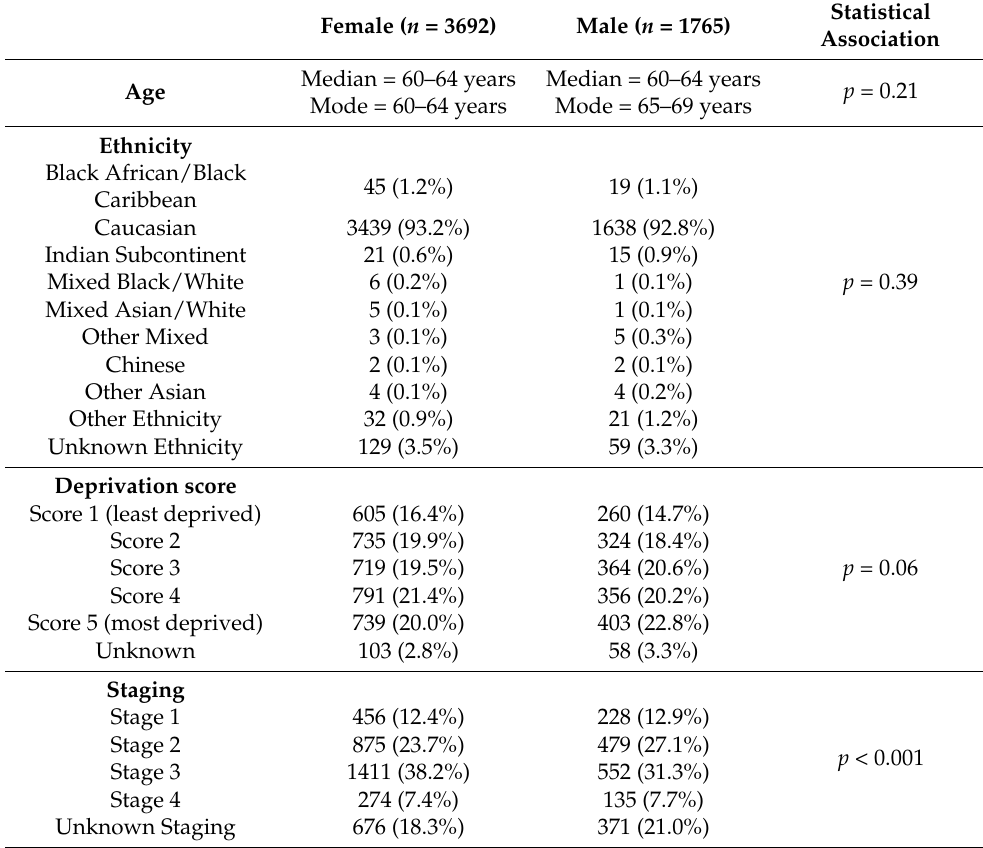
Table 1. Demographics of patients diagnosed with ASCC between January 2013 and June 2018 stratified by